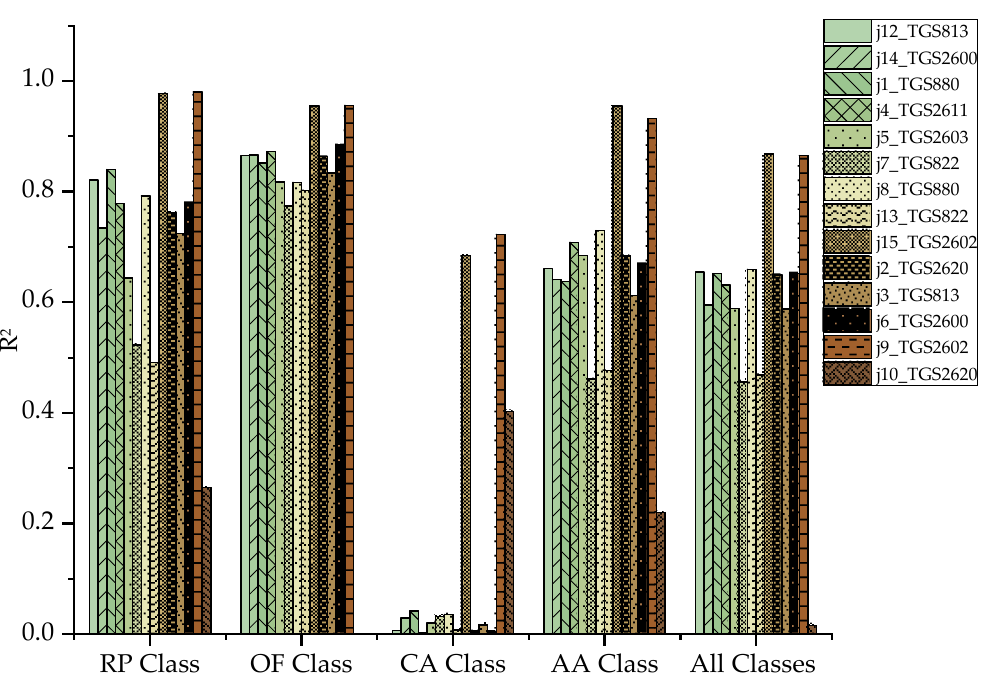
Figure 3. R 2 correlation coefficients values for each sensor and odour class in the training mode. Table 5. Average and standard deviation values of the acquisition temperatures for each odour class.